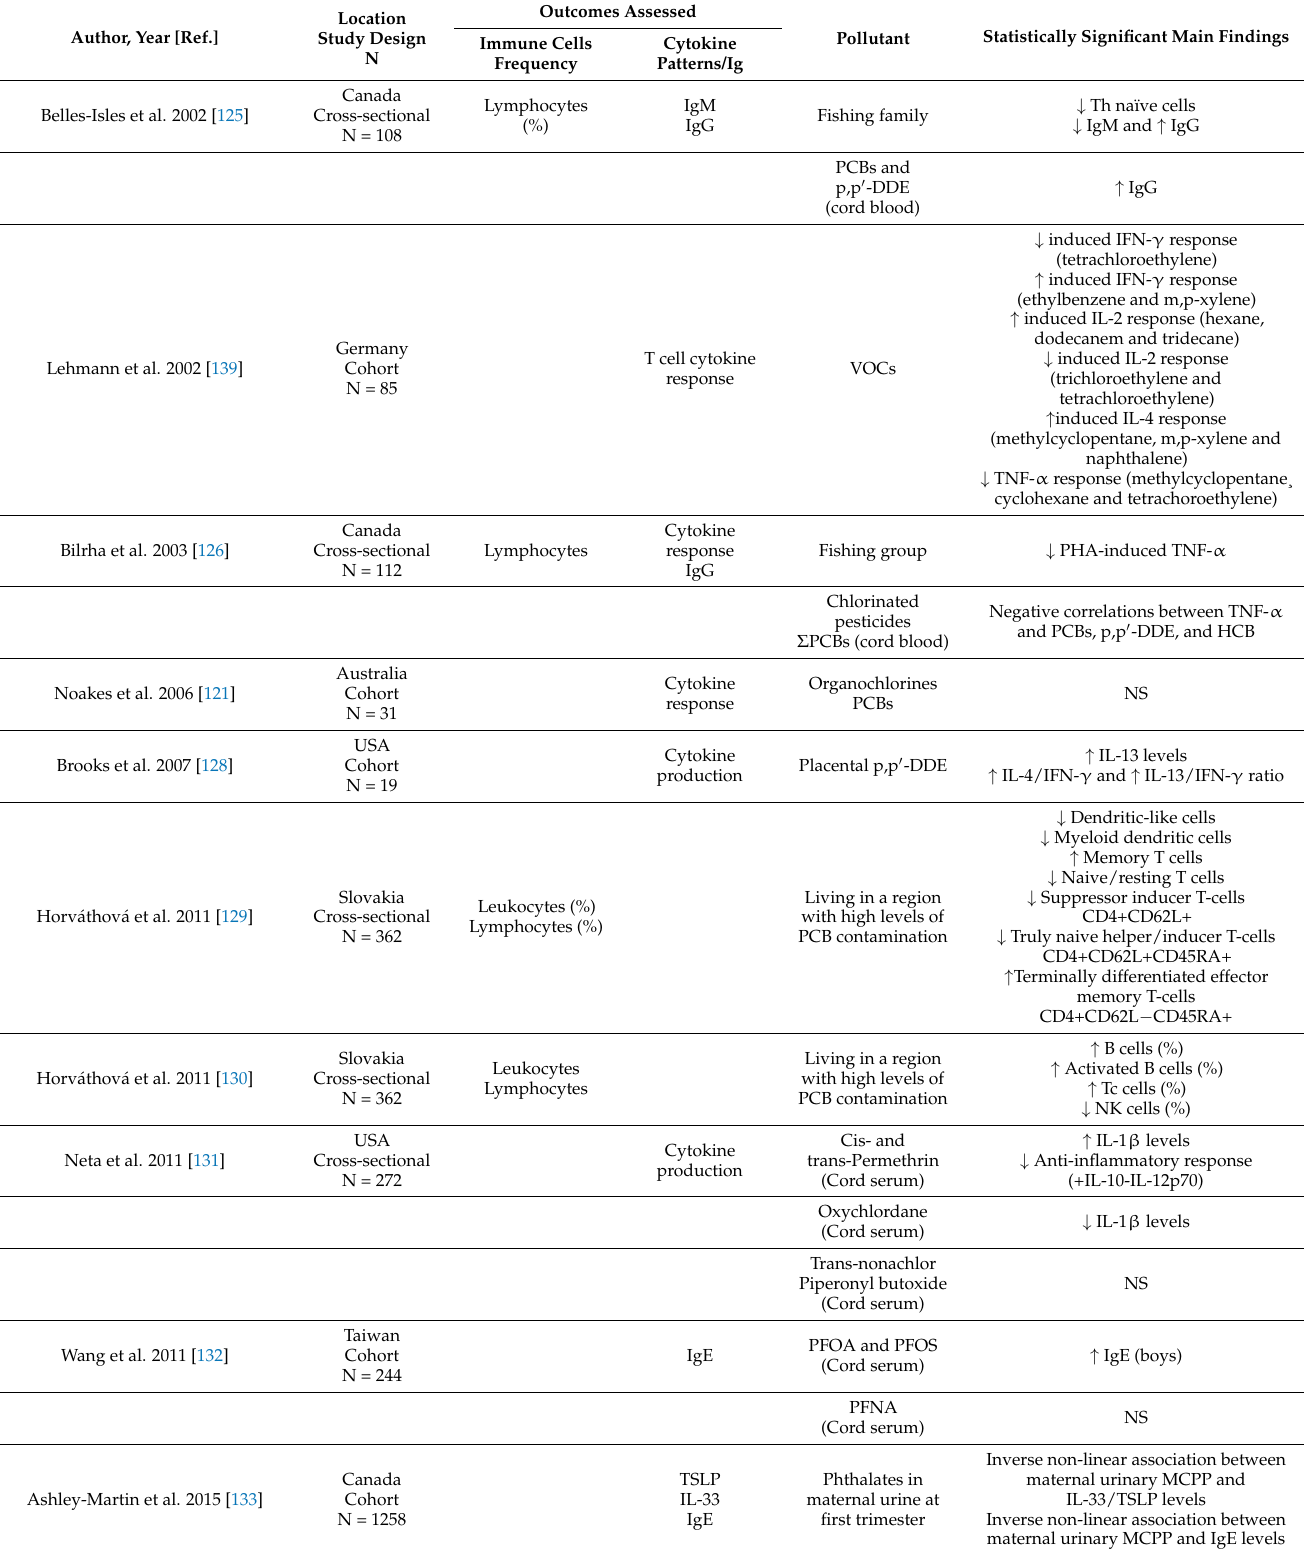
Table 5. Prenatal exposure to environmental organic pollutants and changes in the immune system of neonates (authors ordered by year and then